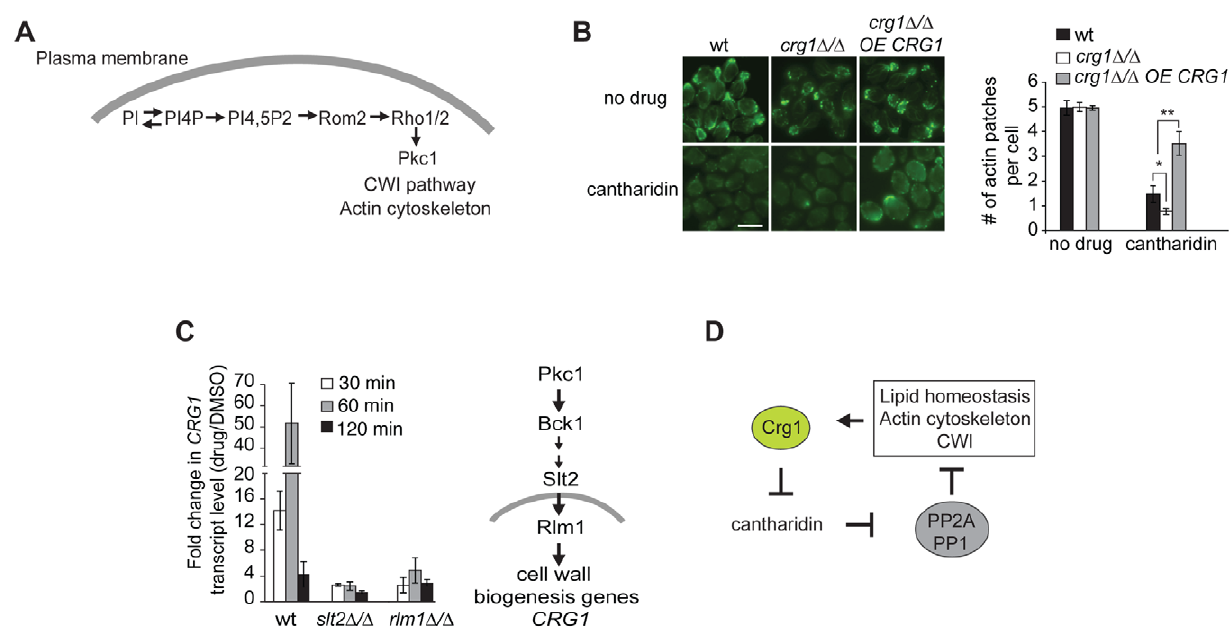
Figure 6. Crg1 is important for actin patch formation during cantharidin treatment. (A) Diagram showing how PIP species are involved in Pkc1-dependent changes in actin cytoskeleton. (B) Crg1 is important for actin patch integrity during cantharidin stress. Wt, crg1 D / D mutant and CRG1 -overexpressing crg1 D / D cells were grown to mid-exponential phase at 30 u C in YPD in the presence of cantharidin (250 m M) or DMSO for 1 hour. Cells fixed with formaldehyde were stained for actin with FITC-phalloidin and visualized by fluorescence microscopy. Bar, 5 m m. The number of actin patches per cell in each sample was quantified. Values are the mean of three independent replicates (n=270–1000), error bars are the standard deviation; * P -value , 0.025, ** P -value , 0.0002 (Student’s t-test). (C) Cantharidin induces CRG1 transcription via the Cell Wall Integrity (CWI) pathway. Cells grown to mid-exponential phase were treated with cantharidin (250 m M) in YPD for indicated time. Total RNA was extracted, cDNA was prepared and analyzed by qRT-PCR. CRG1 transcript levels were normalized to ACT1 . The simplified diagram of CWI pathway is shown. Slt2 is a kinase, Rlm1 is a transcriptional activator governed by the CWI pathway. (D) A preliminary model describing Crg1-cantharidin interaction. See text for details.